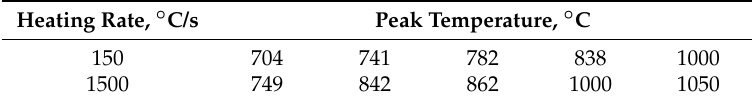
Table 2. Summary of measured peak